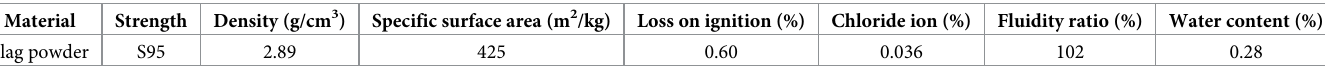
Table 3. Property indices of the slag